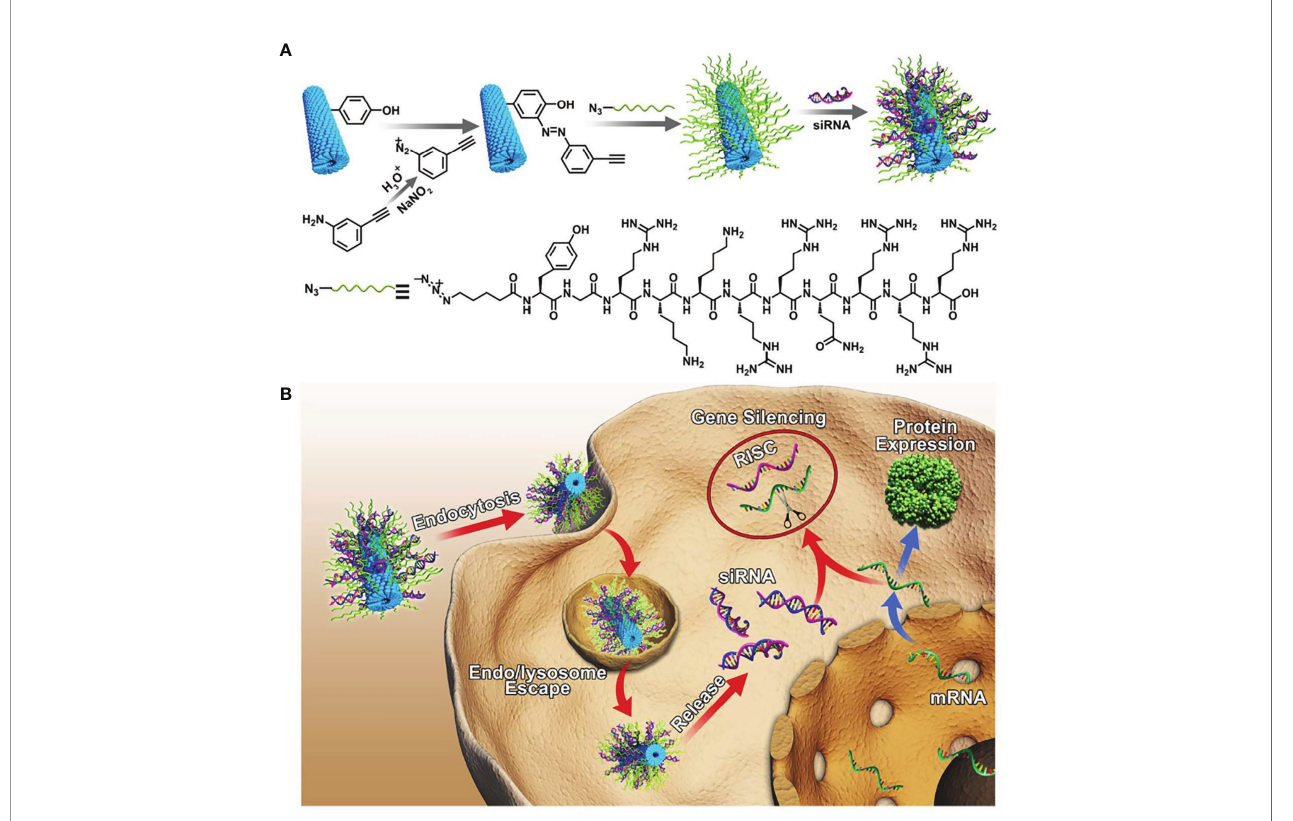
FIGURE 3 | (A) Schematic illustration for the design of siRNA loaded TMV-TAT. (B) Gene silencing process of TMV-TAT within the cells (Tian et al., 2018b) (with reproduction